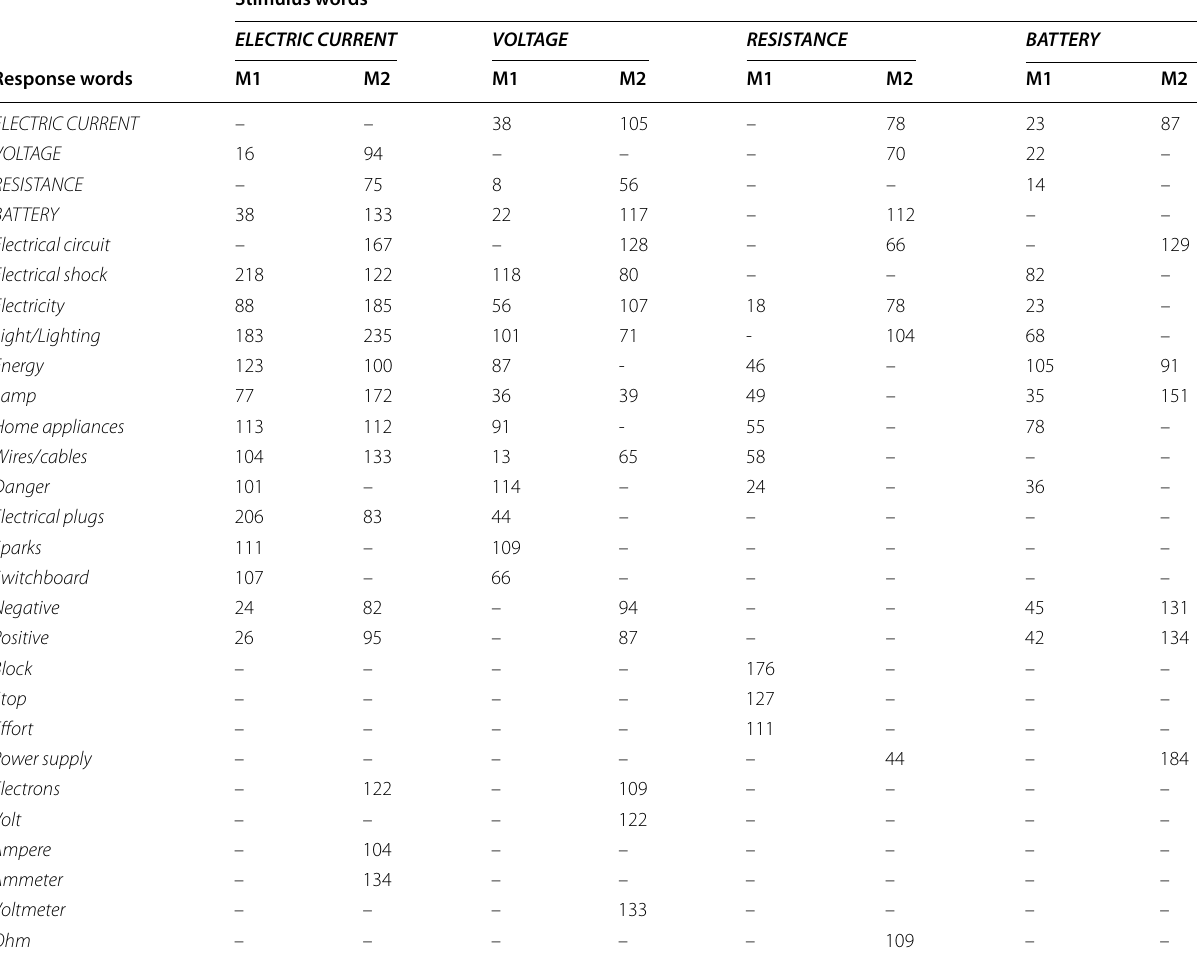
Table 4 WAT frequency table of the experimental